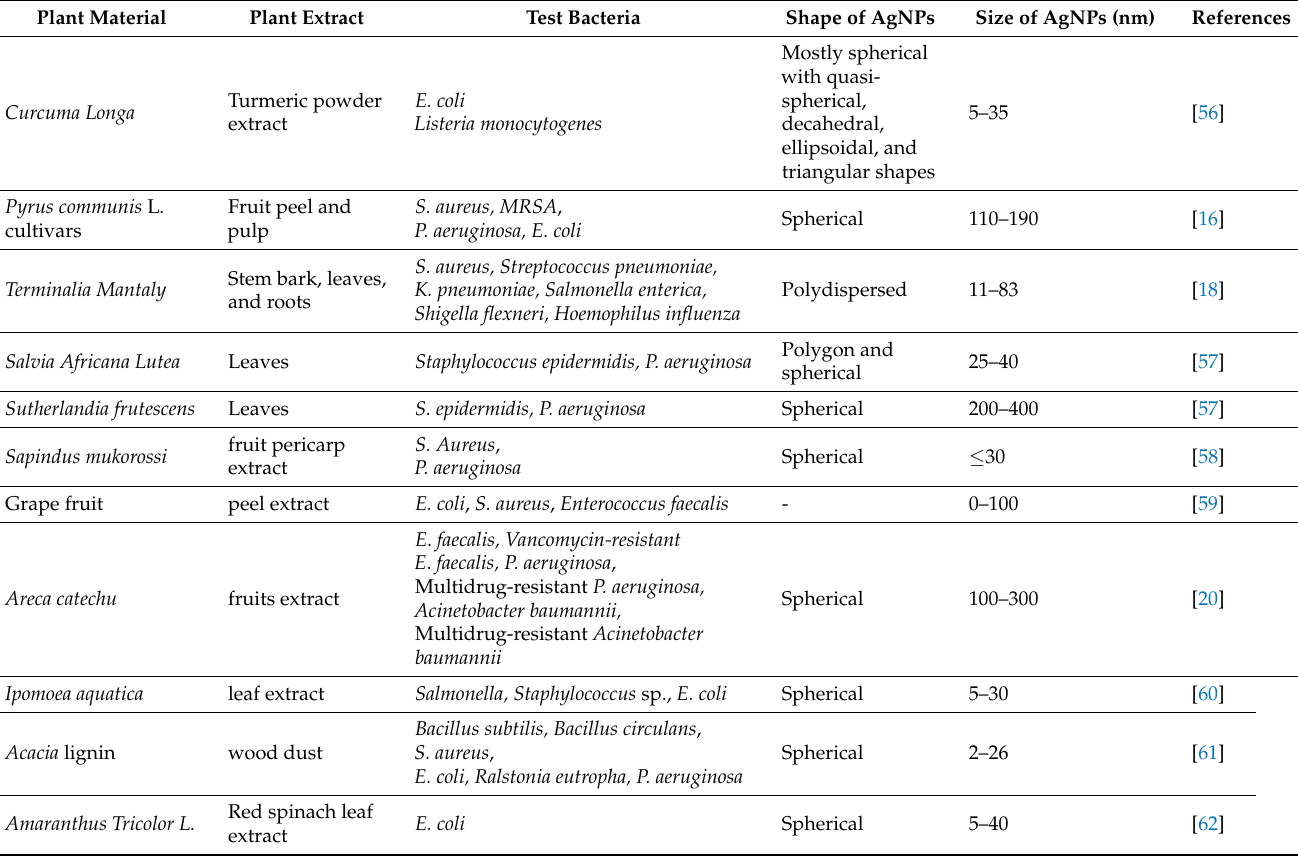
Table 3. Plant-synthesized AgNPs and their anti-bacterial